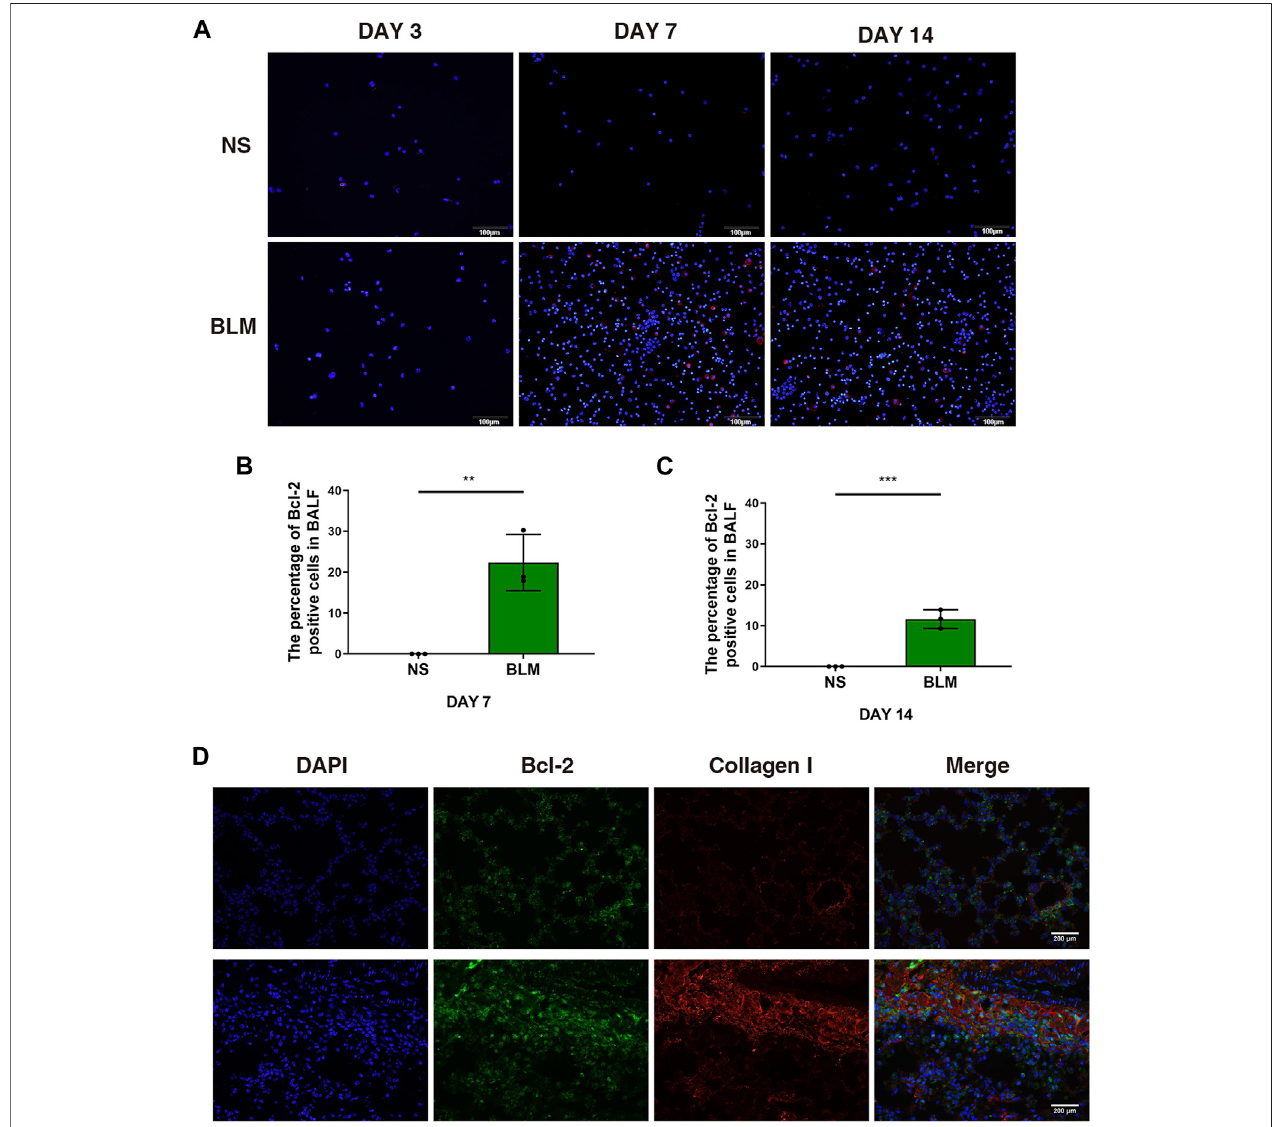
FIGURE 1 | The expression of Bcl-2 was increased in BALF cells and fi broblasts in BLM-induced pulmonary fi brosis. (A – C) Intracellular Bcl-2 expression of BAL cellswasassessedbyimmuno fl uorescenceassay,andthepercentageofBcl-2positivemacrophageswasdetermined. (D) RepresentativeimagesofcollagenIandBcl- 2show fl uorescentstaininginlungtissuesofmiceinducedbyBLMatday14.Thedataarepresentedasmeans ± SDofanexperimentperformedthreetimes.** p < 0.01, *** p < 0.001. n (cid:2) 5. BLM, bleomycin; BAL, bronchial alveolar lavage; NS, normal saline; Bcl-2, B-cell